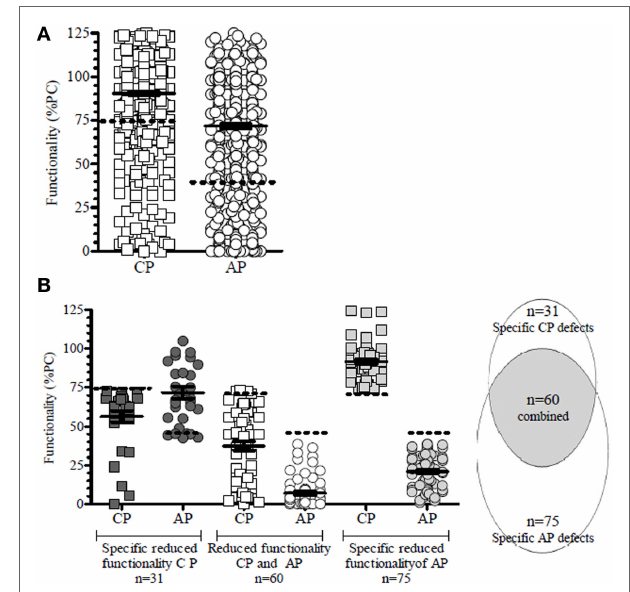
FigUre 2 | lectin pathway functionality correlation with MBl- concentration . (a) In a longitudinal series of more than five consecutive time points per patient, MBL concentrations were measured in oncology patients ( ● ) and correlated to the LP functionality ( r 2 = 0.907). Functionality is depicted as percentage of a positive control (%PC). (B) MBL genotype was correlated to MBL serum levels. MBL deficiency as defined as MBL levels below 500 ng/mL is depicted as a dotted line. Because of the observed effects of chemotherapy of the pediatric ALL-11 protocol ( ○ ) on the lectin pathway of complement, these ALL patients were excluded from the analysis ( n = 5) (Keizer et al., submitted). MBL deficiency as defined by MBL levels below 500 ng/mL is depicted by a dotted